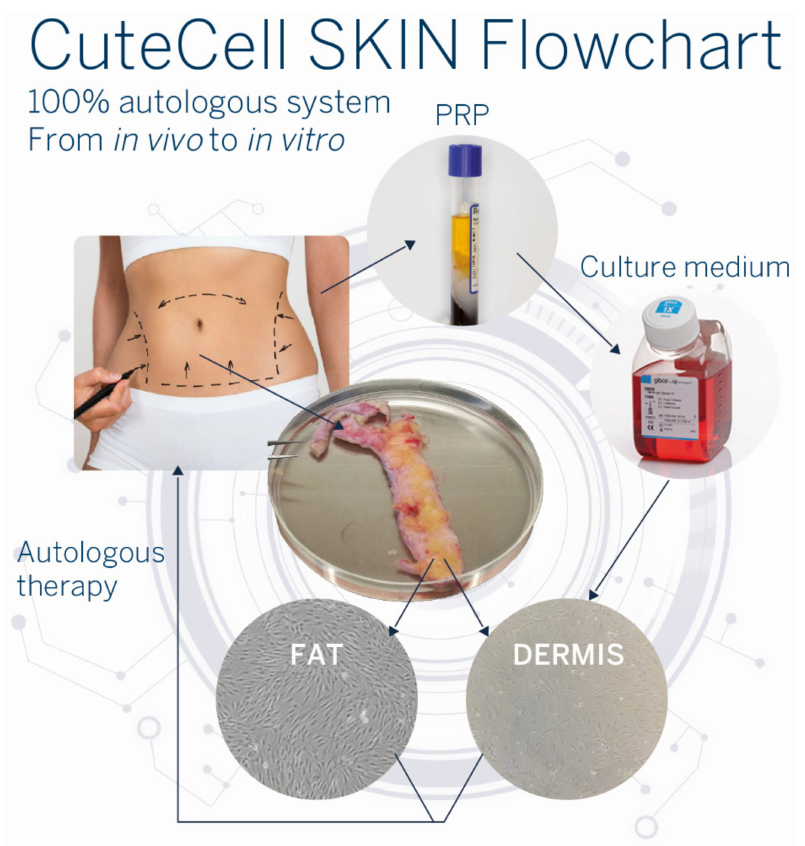
Figure 6. CuteCell SKIN flowchart. During surgical abdominoplasty, a piece of skin is retrieved from the patient as well as blood from venous puncture. In the laboratory, cells from skin (fat or dermis parts) are isolated for in vitro cultures. The patient’s blood is processed with the CuteCell PRP device. The prepared PRP can be added to the culture medium in replacement of FBS to expand the patient’s cells in